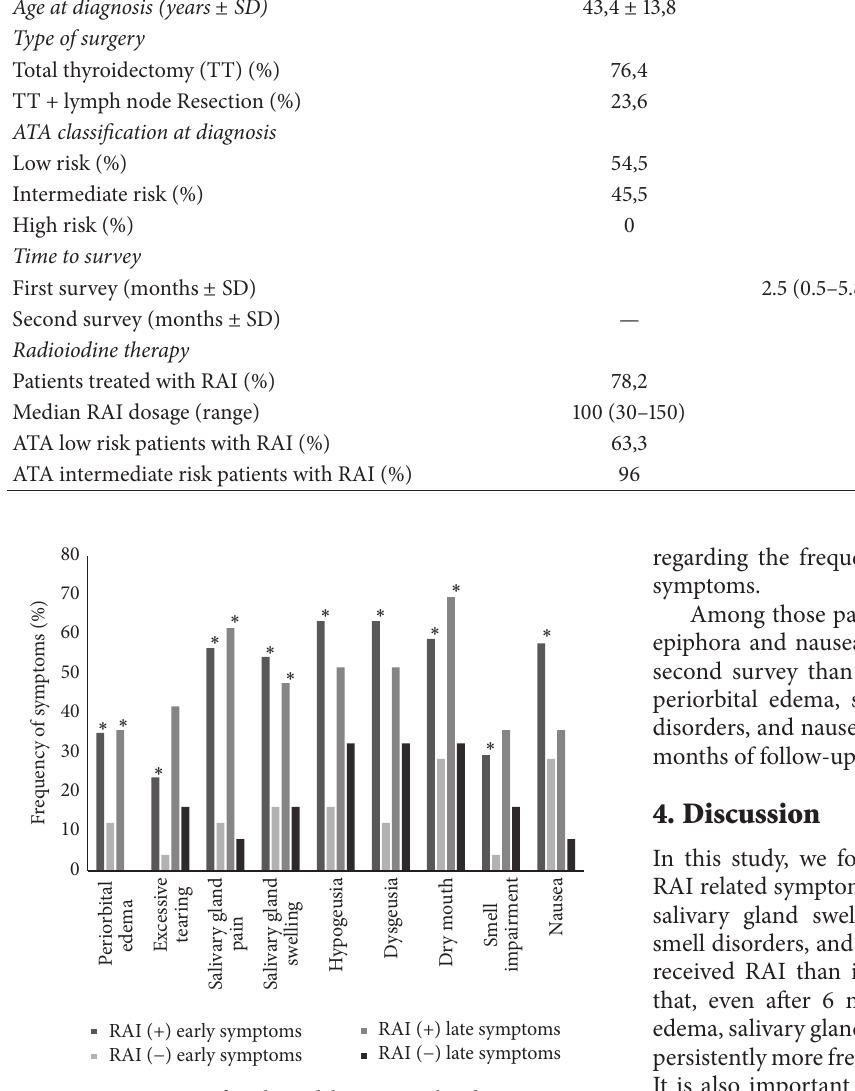
Figure 1: Frequency of early and late RAI related symptoms in patients with DTC treated with or without RAI. ∗ shows statistically significant differences ( 𝑝 < 0.05 ) between patients who received RAI and those who did